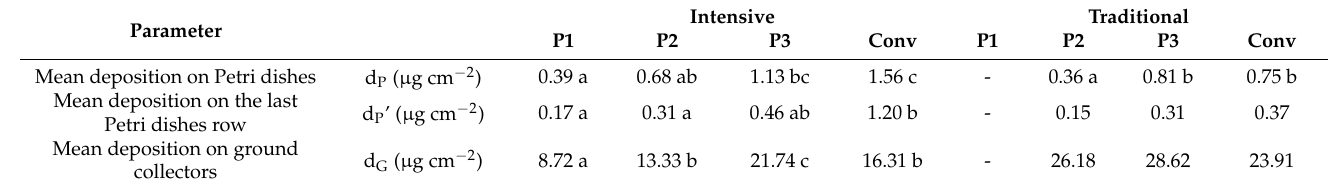
Table 6. Mean results and homogeneous groups according to Bonferroni’s test for the parameters related to the spray losses. Letters after figures indicate the post-hoc test homogeneous group in the case statistically significant differences were found.